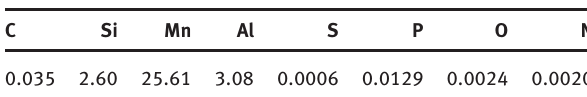
Table 1: Chemical composition of specimens (mass %).